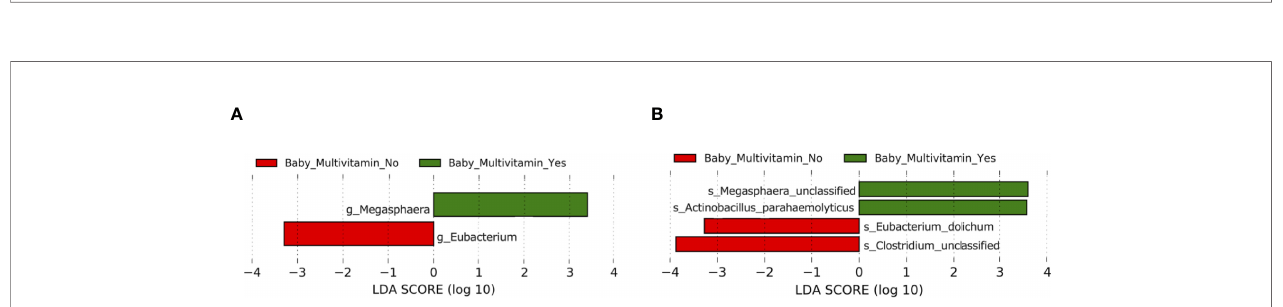
FIGURE 5 | Comparison of diversity indices between hypertensive pregnancy (HP) infants ( n = 8) and normotensive pregnancy (NP) infants ( n = 10) based on faecal samples collected at 6 months of age. Alpha diversity measured by (A) Shannon index (B) Pielou ’ s evenness (C) Faith ’ s phylogenetic diversity (D) Observed operational taxonomic units (OTUs). Boxes represent the interquartile range (IQR), the line inside the box indicates the median and whiskers represent values 1.5 × IQR from the fi rst and third quartiles respectively. Differences between mothers and babies were tested using the Wilcoxon sum rank test and false discovery rate (FDR) corrected. * P < 0.05. (E) Principal Coordinates Analysis (PCoA) of microbiota community structure in HP babies and NP babies. The points represent individual samples from babies and the ellipse illustrates the 95% con fi dence intervals of multivariate normal distribution. (F) Differentially abundant bacterial taxa as identi fi ed by Linear discriminant analysis Effect Size (LEfSe). Bacterial taxa were classi fi ed as differentially abundant if their P value was < 0.05 and their linear discriminant analysis (LDA) log score was > 2. Taxa enriched in the HP babies are indicated by red, and taxa enriched in the NP babies are indicated by green. Taxon levels are abbreviated with p_ = phylum, c_ = class, o_ = order, f_ = family, g_ = genus and s_ = species. LDA effects sizes and signi fi cant P values are in Supplementary Table 14